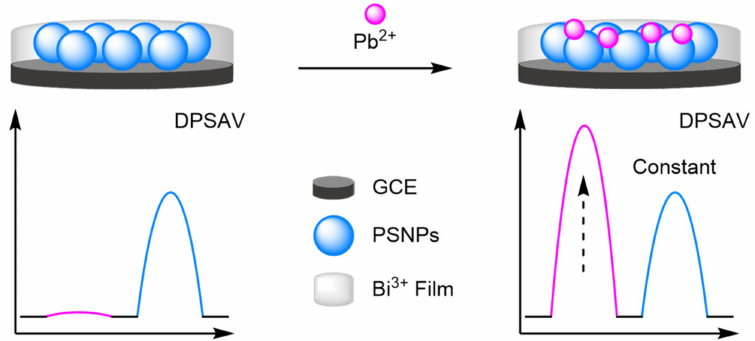
Figure 33. Schematic representation of Bi(III)-assisted modified electrode for the detection of Pb 2+ . (e)